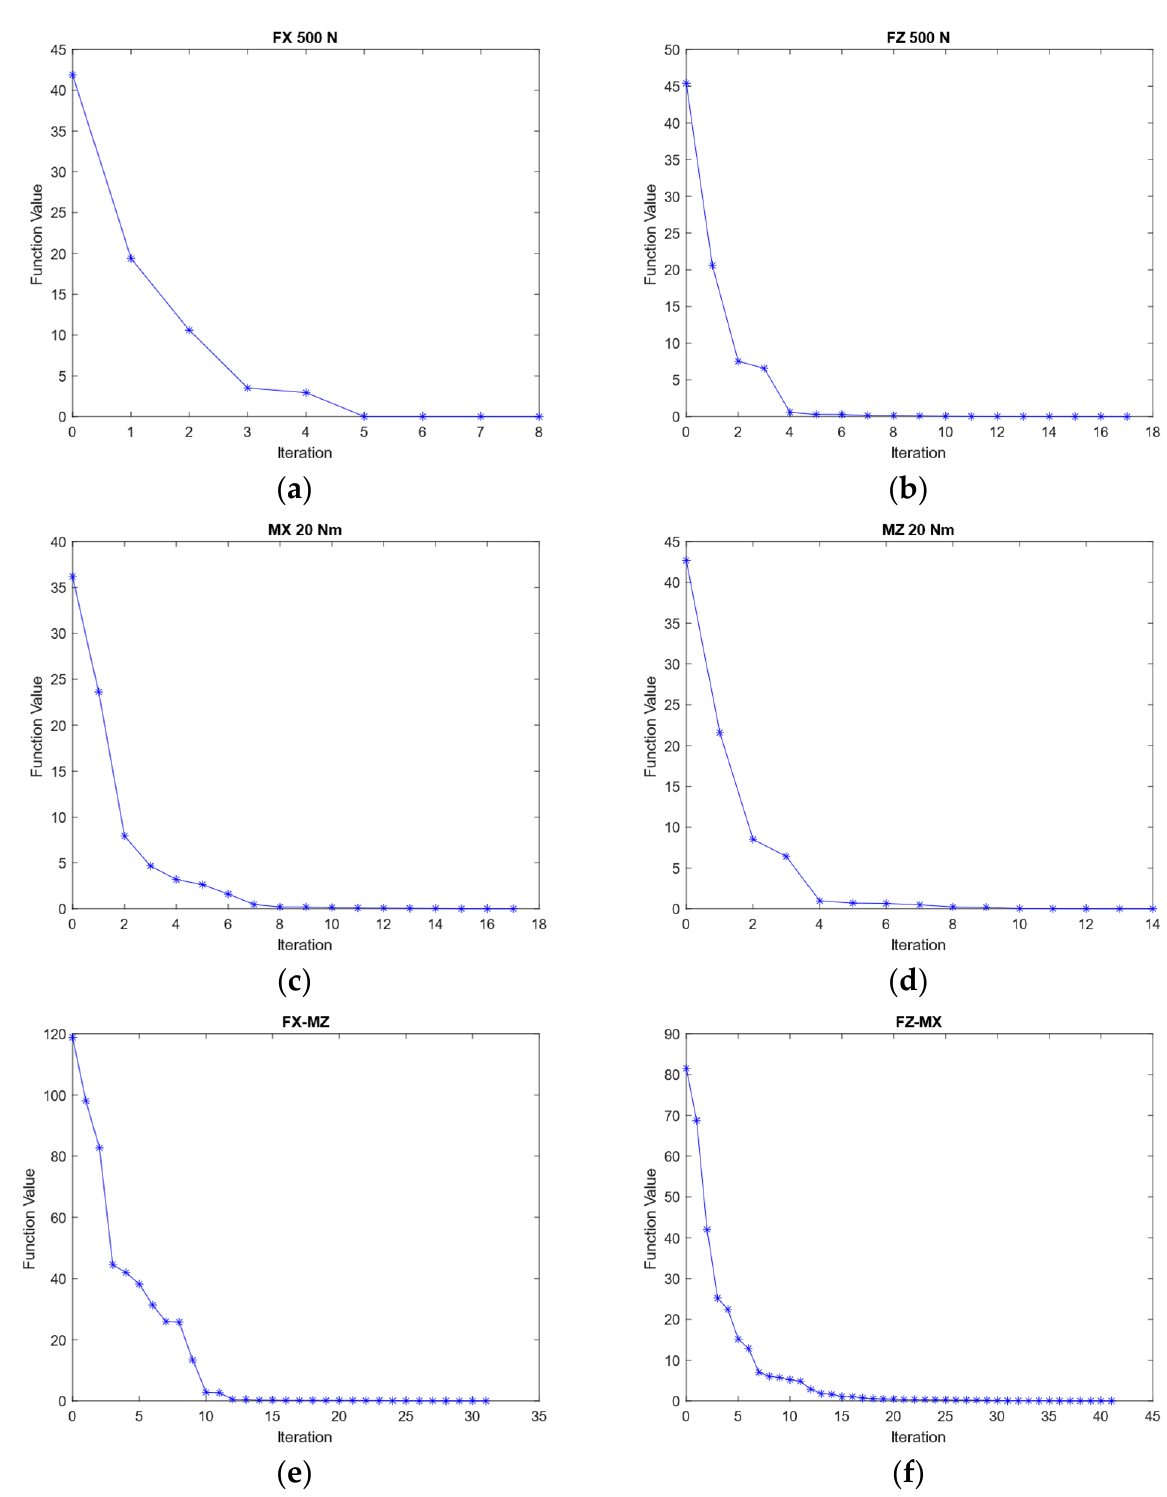
Figure 5. Function value of optimization during different pure load ( a ) F X 500 N, ( b ) F Z 500 N, ( c ) M X 20 Nm, and ( d ) M Z 20 Nm, and during multiple loads ( e ) F X 500 N and M Z 20 Nm, and ( f ) F Z 500 N and M X 20 Nm. Table 3. Result of optimization with different pure loads and multiple loads.